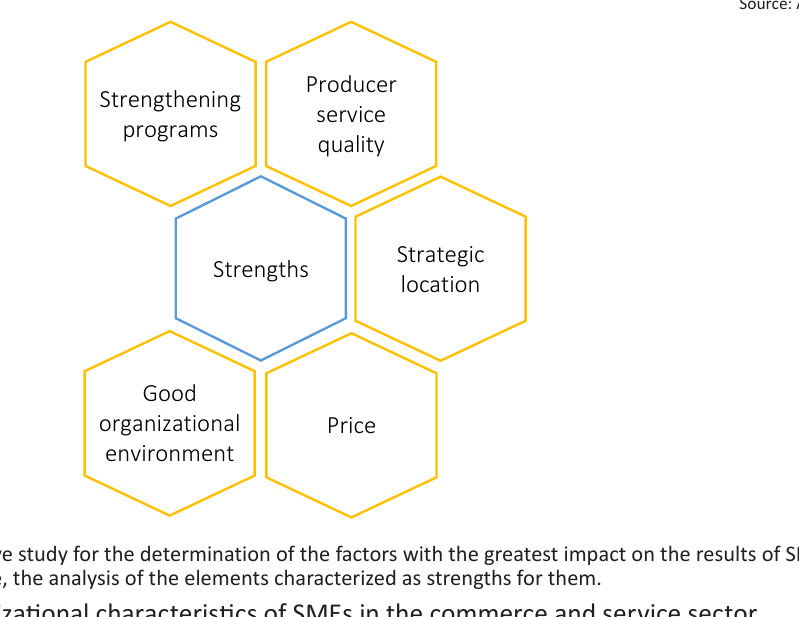
Figure 1. Organizational characteristics of SMEs in the commerce and service sector of the Municipality of Palmira –